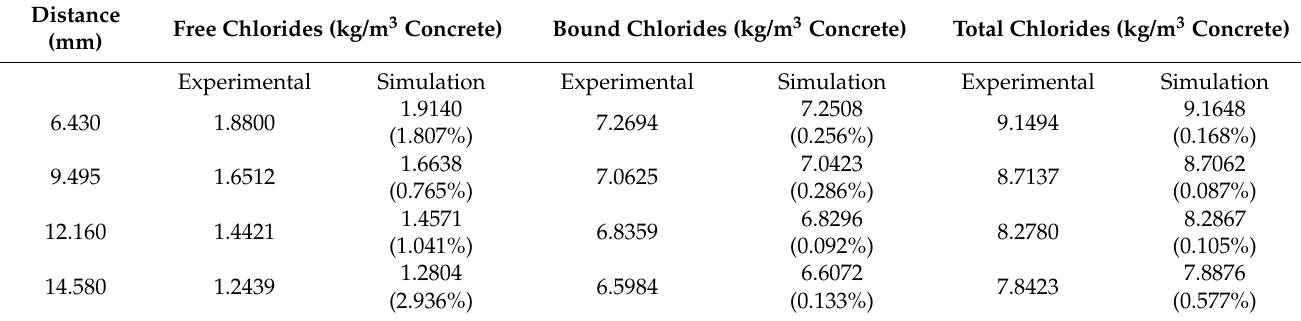
Table 4. Deviations between experimental and numerical solutions.